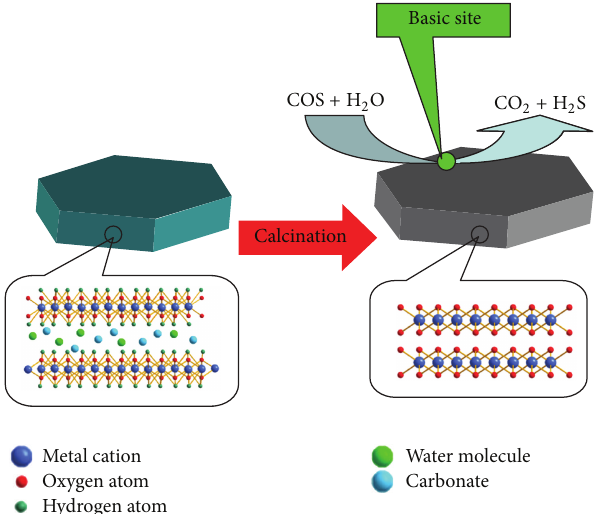
Figure 1: Hydrolysis of COS on the hydrotalcite-derived